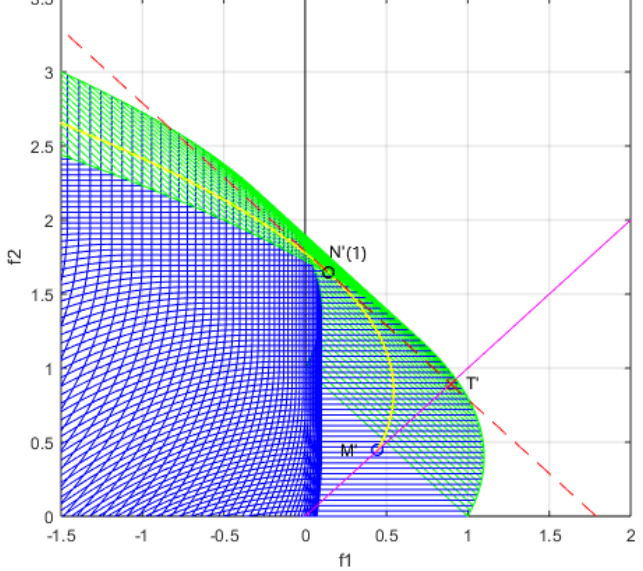
Figure 5. Sharing solution T (cid:48) .